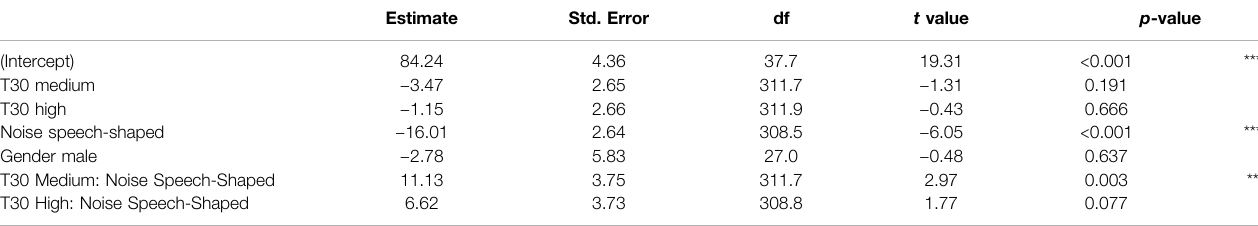
TABLE7| LMEmodels fi tbyREMLfortheresponsevariableself-reportedvocalcomfortandthe fi xedfactors1)T30,2)noise,3)gender,and4)theinteractionbetweenT30 and noise.